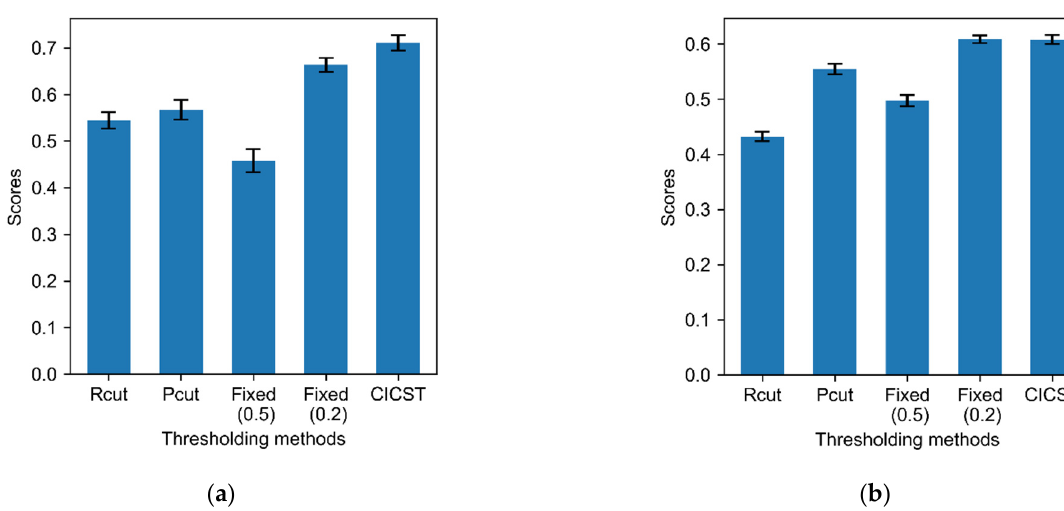
Figure 4. Comparisons of the scores achieved by different thresholding methods after the costs are changed. ( a ) Scores of different thresholding methods after 50% of the entries of the benefit matrix are increased by 50%; ( b ) Scores of different thresholding methods after 50% of the entries of the benefit matrix are decreased to 70% of the original values.